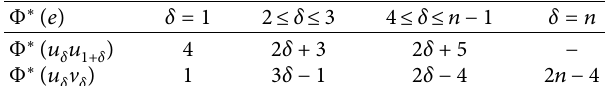
Table 16: Edge labeling of Φ ∗ ( e ) .